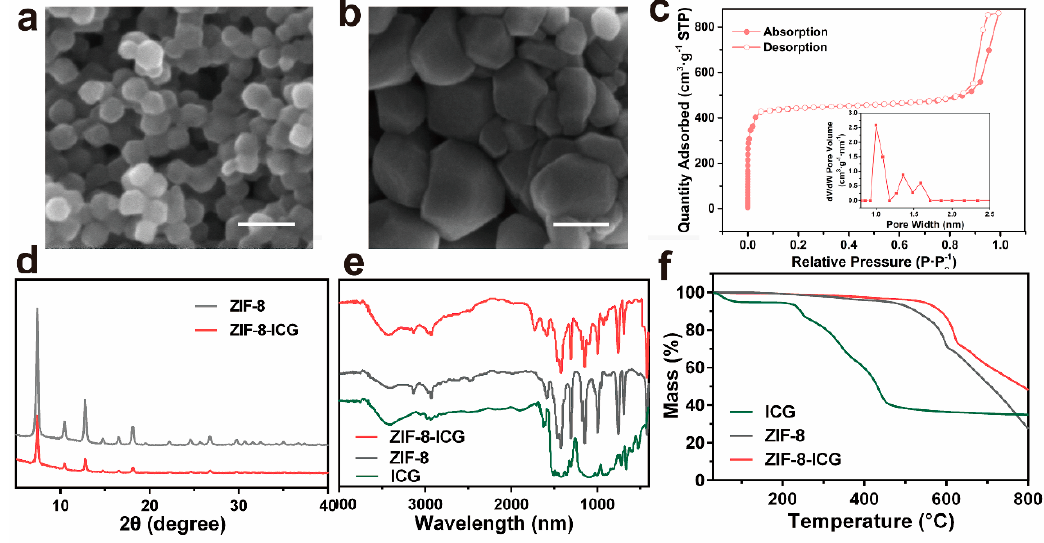
Figure 2. SEM images of ( a ) ZIF-8 and ( b ) ZIF-8-ICG (Scale bar: 100 nm); ( c ) N 2 adsorption-desorption isotherm of ZIF-8, the insert was pore size distribution of ZIF-8; ( d ) powder X-ray diffraction (PXRD) patterns of ZIF-8 before and after ICG loading; ( e ) FT-IR spectra of ICG, ZIF-8, and ZIF-8-ICG; ( f ) TGA results of ICG, ZIF-8, and ZIF-8-ICG.